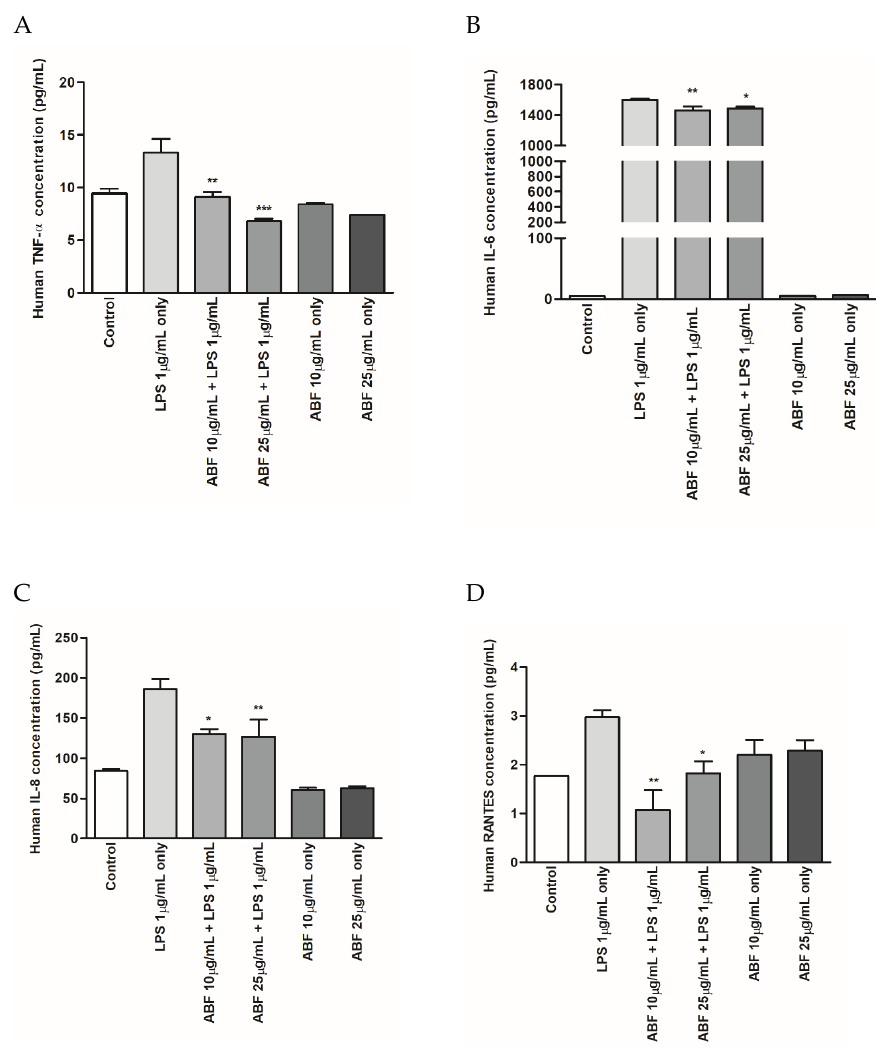
Figure 4. E ff ects of aronia bioactive fraction (ABF ® ) on inflammatory cytokines in lipopolysaccharide (LPS)-stimulated BEAS-2B Cells. Cells were pretreated with ABF ® (10 and 25 µ g / mL) for 6 h and then treated with LPS (1 µ g / mL) for 48 h. Cell culture supernatants were collected and tumor necrosis factor (TNF)- α ( A ), interleukin (IL)-6 ( B ), IL-8 ( C ), and regulated upon activation, normal T cell expressed and presumably secreted (RANTES) ( D ) production was assessed by enzyme-linked immunosorbent assay. Values are expressed as means ± standard deviation (SD) of triplicate experiments. * p < 0.1, ** p < 0.05, *** p < 0.01 indicate significant di ff erences as compared to the LPS-stimulated